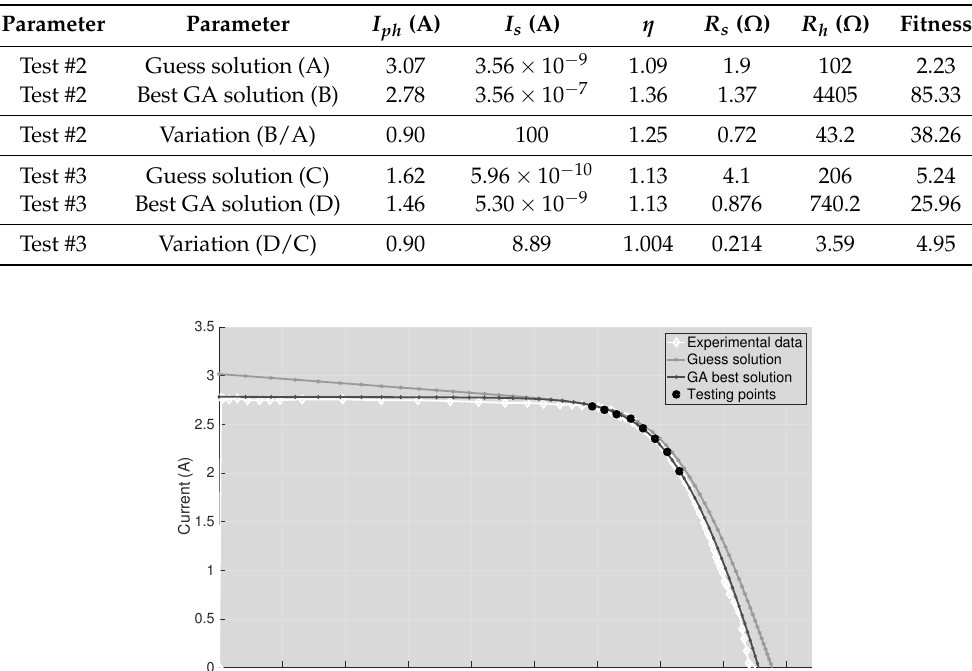
Table 7. SDM parameters comparison for Tests #2 and #3.